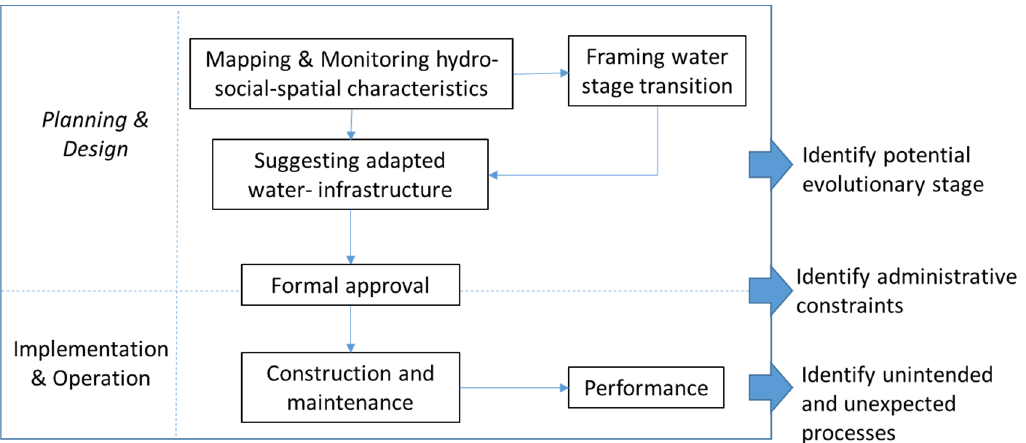
Figure 3. The procedure employed to identify potential dynamics occurred during and after implementation of a prototype to simulate a transitional stage in a specific neighborhood.